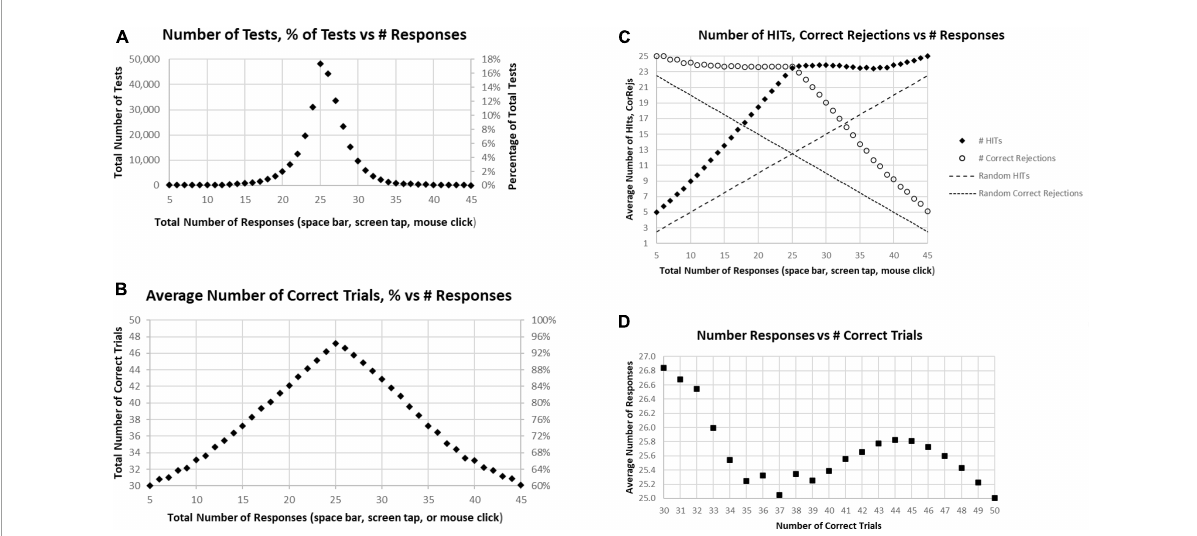
FIGURE2 (A) Number of tests (left scale) and percentage of tests (right scale) having the specific number of responses. The optimal number is 25, consistent with the peak. (B) Average number correct (HITs plus Correct Rejections) of tests (left scale) and percentage of correct responses (right scale). While the number of correct responses ranged from 5 to 45, the optimal number, 25, has only an average number correct equal to 47.2. (C) Separated average number of HITs and Correct Rejections plotted for total responses. The pattern is clearly not random (dashed lines); so, when the number of responses is less than 25, the number of HITs declines progressively with a relatively stable number of Correct Rejections, and when the number of responses is more than 25, the number of HITs is relatively stable, with the number of Correct Rejections progressively declining. (D) Average number of responses for each number correct, from 30 (60% correct) to 50 (100% correct). Note 25 is optimal, but all averages are above 25 except for 100% correct. Less than 37 correct is associated with an increasing number of responses associated with fewer correct